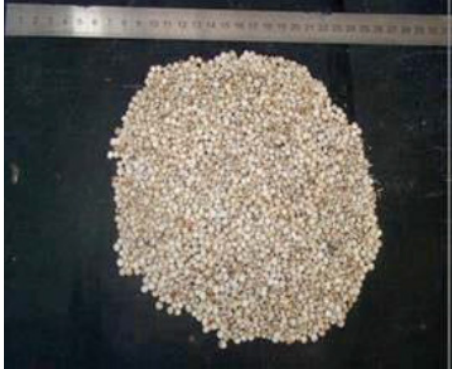
Figure 5: Corn used in the experiment.